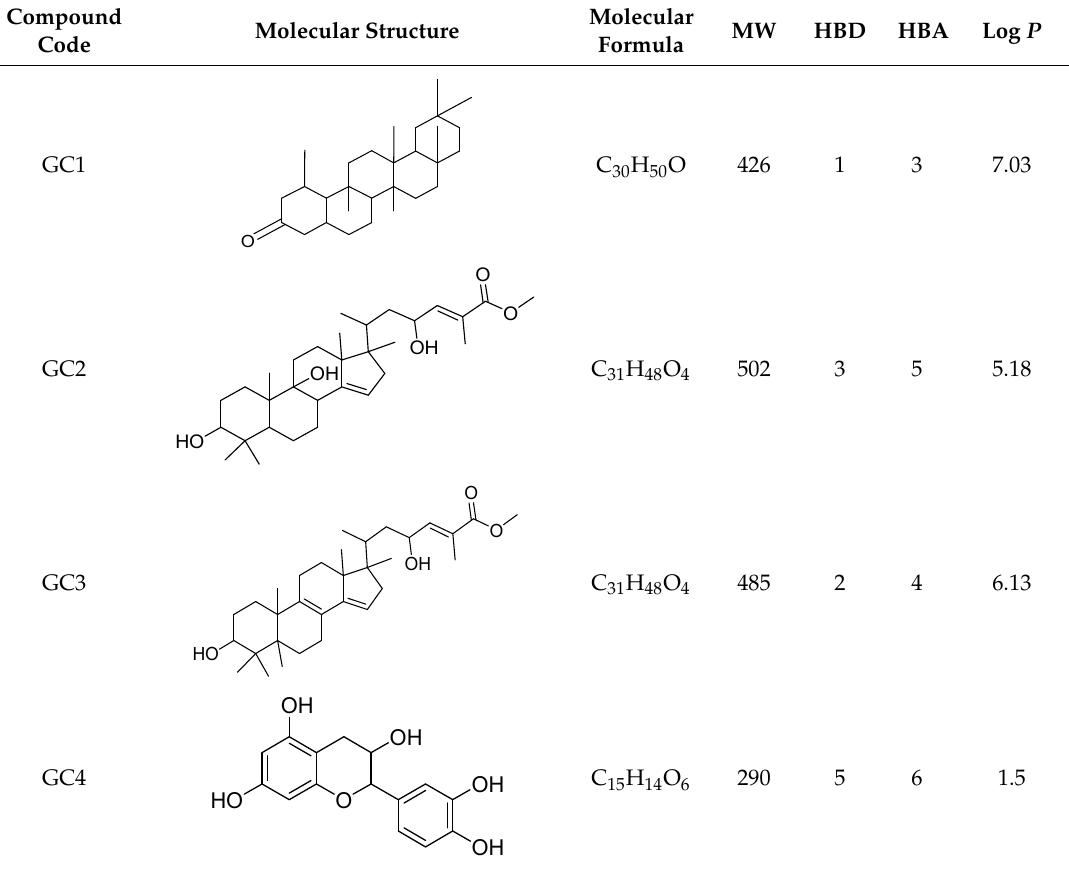
Table 2. Data on the structures, physicochemical properties, and Lipinski’s rule of five of the isolated compounds.